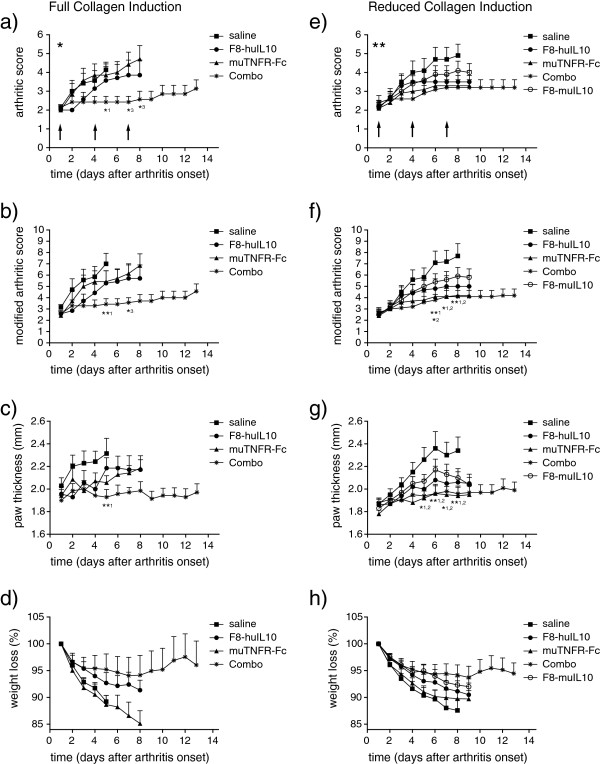
Therapy studies in mice with collagen-induced arthritis. (a) to (d) Mice were immunized according to the full collagen induction protocol, included in the therapy when showing symptoms and injected on days 1, 4 and 7 (arrows). *Fifteen of 50 mice (30%) developed an explosive disease and could not be included in the therapy. Mice received saline subcutaneously (s.c.; squares), 200 μg F8-huIL10 s.c. (circles), 10 μg muTNFR-Fc intravenously (i.v.; triangles) or a combination of F8-huIL10 and muTNFR-Fc (crosses). The clinical score was evaluated daily and expressed as (a) arthritic score or (b) modified arthritic score with mean and standard error of the mean (SEM) of seven mice per group. (c) Paw swelling was measured daily and paw thickness expressed as the mean of all four paws (mean and SEM). (d) Weight was monitored daily and expressed as percent of weight loss (mean and SEM). (e) to (h) Mice were immunized according to the reduced collagen induction protocol. **Six of 60 mice (10%) developed disease too rapidly and could not be included in the therapy. Mice received saline s.c. (squares), 200 μg F8-huIL10 s.c. (circles), 30 μg muTNFR-Fc i.v. (triangles), a combination of F8-huIL10 and muTNFR-Fc (crosses) or 200 μg F8-muIL10 s.c. (open circles). (e) Arthritic score or (f) modified arthritic score with mean and SEM of 10 mice per group. (g) Paw swelling was measured daily and paw thickness expressed as the mean of all four paws (mean and SEM). (h) Weight was monitored daily and expressed as percent of weight loss (mean and SEM). *1P <0.05, **1P <0.01 combo versus saline; *2P <0.05, **2P <0.01 muTNFR-Fc versus saline; *3P <0.05 combo versus muTNFR-Fc.